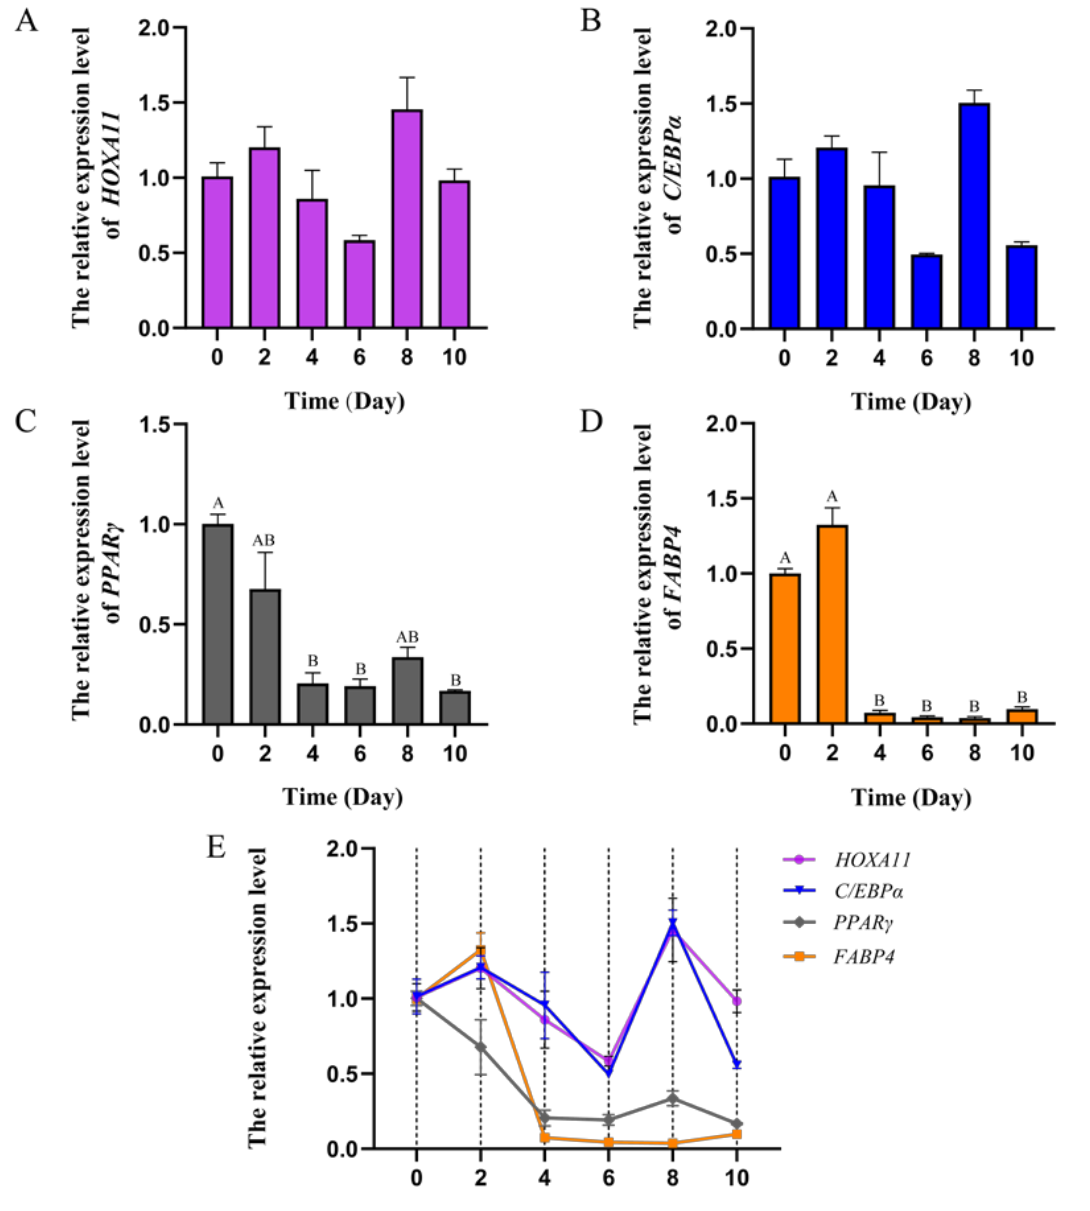
Figure 4. Expression characteristics of HOXA11 and fat-development-associated genes in bovine adipocytes. Expression trend of HOXA11 ( A ), C/EBPα ( B ), PPARγ ( C ) and FABP4 ( D ) in bovine adipocytes in differentiation medium (0, 2, 4, 6, 8 and 10 days; n = 3), and the expression trend line chart of these genes ( E ). The columns with different superscripts ( A , B ) within each figure differ significantly at p < 0.01 level. Bars represent mean, error bars represent standard error of mean (SEM).